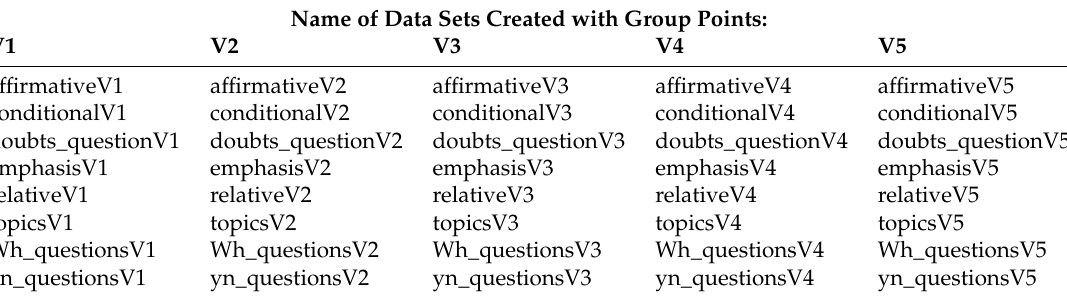
Table 7. Data sets obtained from the facial points of the five groups created